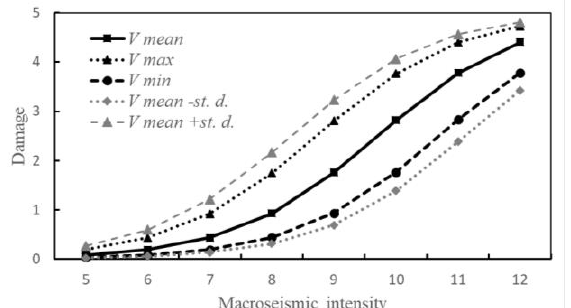
Figure 10. Damage curves for the aggregate studied